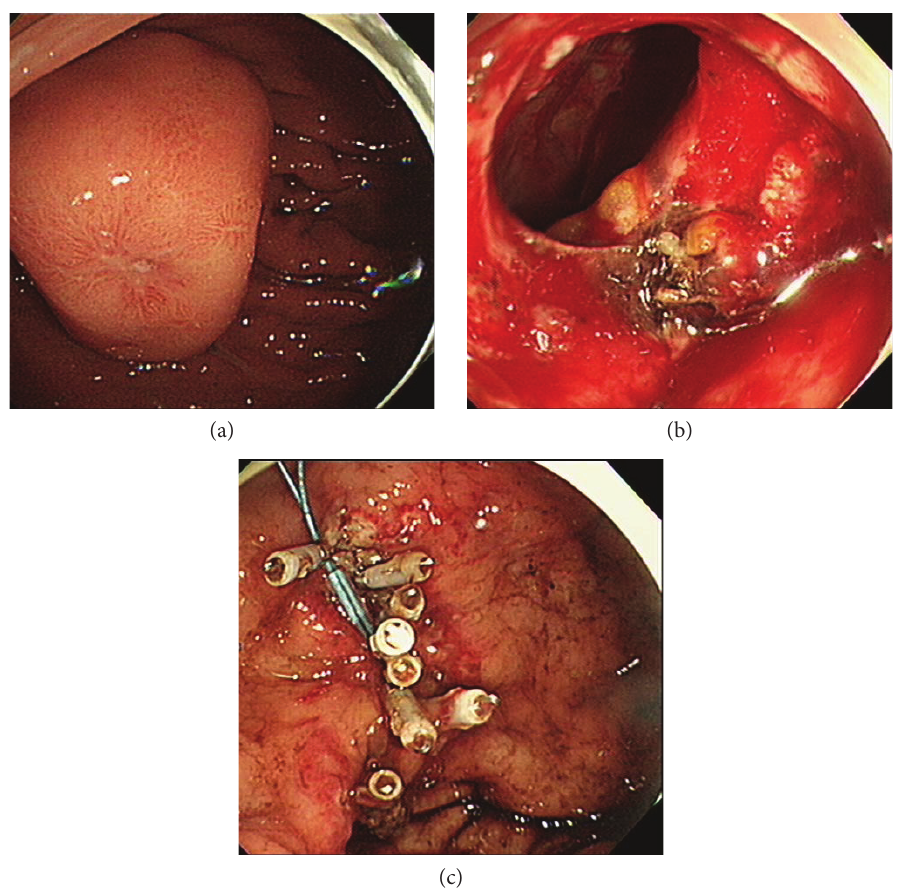
Figure 1: (a) A 2.8 cm GIST was observed on the anterior wall of the fundus. (b) An intra-abdominal space was detected through the perforation site during the procedure. (c) The perforation site was successfully closed using endoclips and a detachable